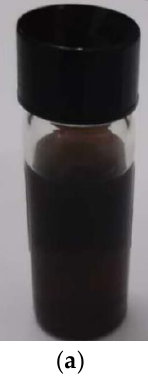
Figure 2. Absorption spectrum of PtNPs. ( a ) Colloid of PtNPs. ( b )SEM image. ( c ) Linear absorption spectrum.